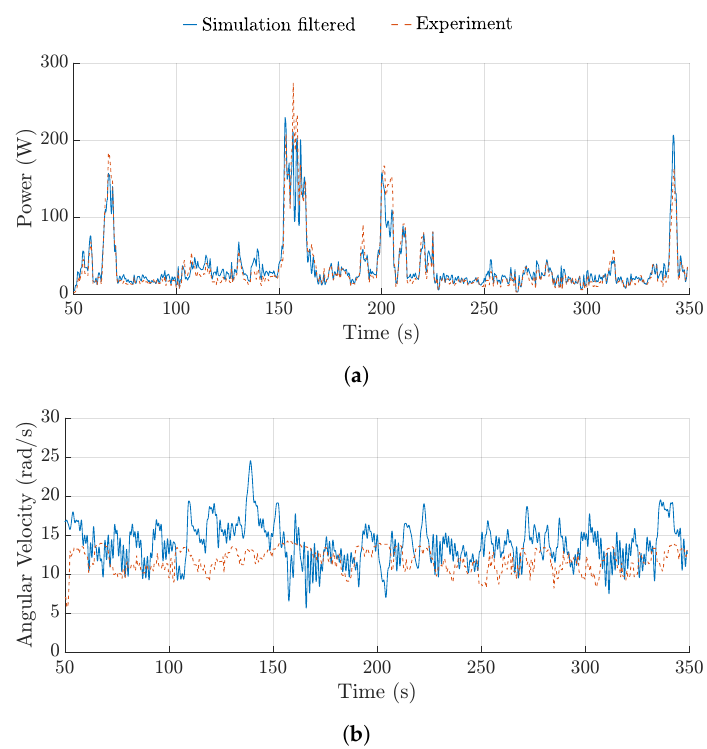
Figure 16. Comparison between experimental data and multi-spring model with a low pass filter. ( a ) Power output comparison; ( b ) Angular velocity